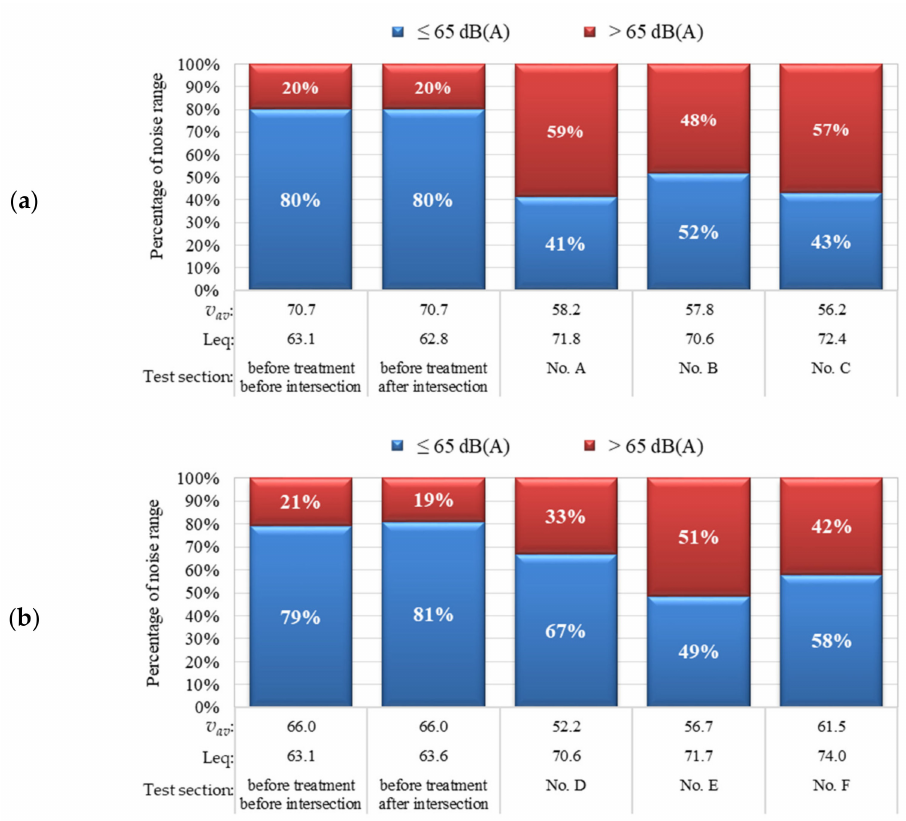
Figure 9. Percentage shares of noise on the analysed test sections: ( a ) Westbound carriageway—ca. 600 m long straight approach section of the road; ( b ) Eastbound carriageway—ca. 130 m long straight approach section of the road.